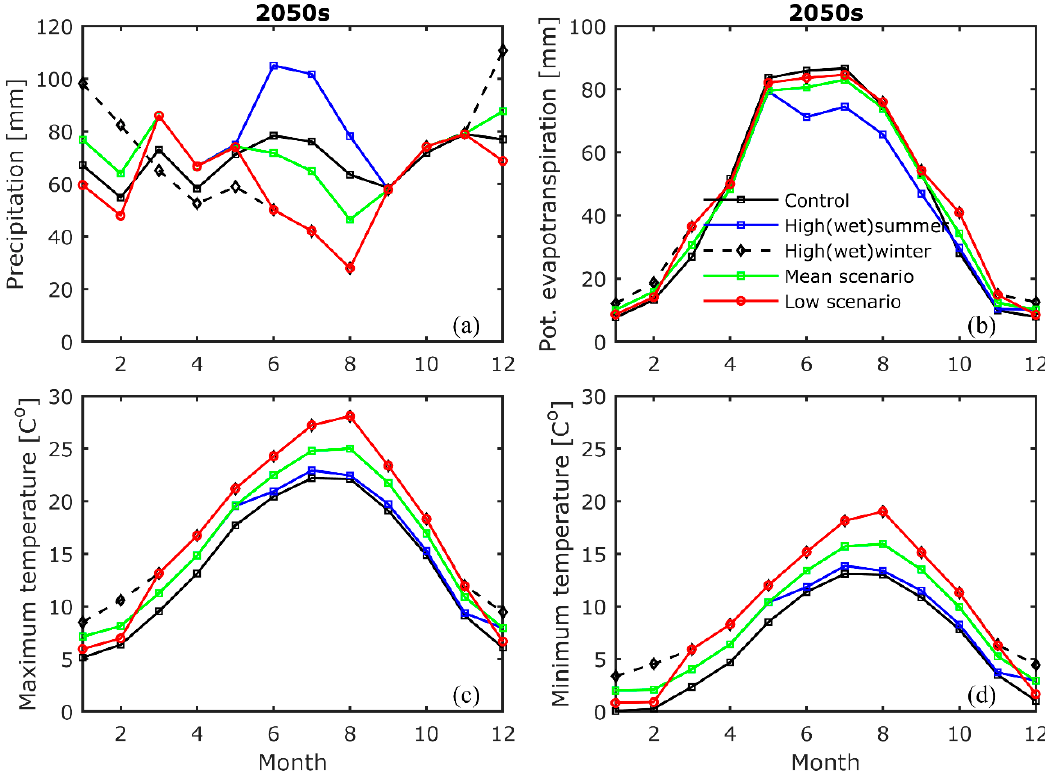
Figure 2. The average monthly precipitation ( a ), potential evapotranspiration ( b ), maximum temperature ( c ), and minimum temperature ( d ) for the control period (1961–1960) and four climate change scenarios of 2050s (2036–2065).